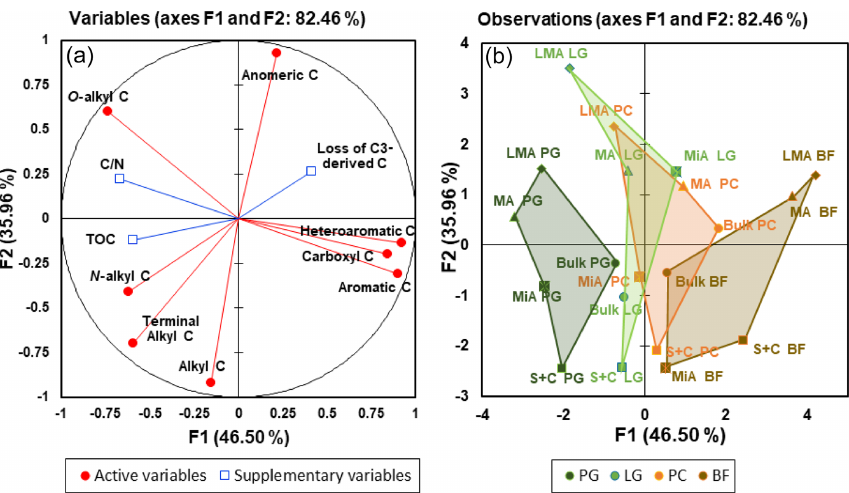
Figure 6. Results of principal component analysis applied to 13 C NMR analysis of the C distribution within different aggregate fractions from soils under different land uses. Projected loadings of the soil-measured variables (a) and representation of the light fraction C isolated from aggregate size fractions of the four different treatments on the plain, as defined by the two first principal components (b) . Labels for samples and variables refer to Tables 1, 2, and